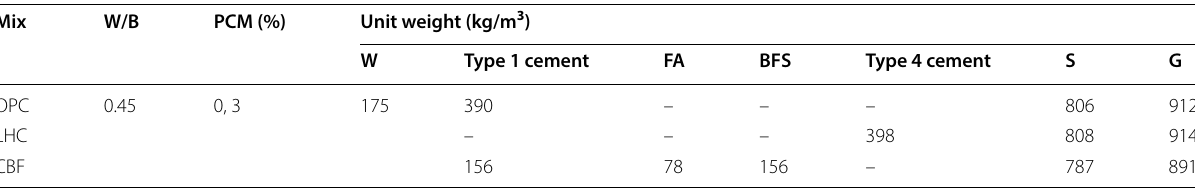
Table 1 Mixture design of concrete.